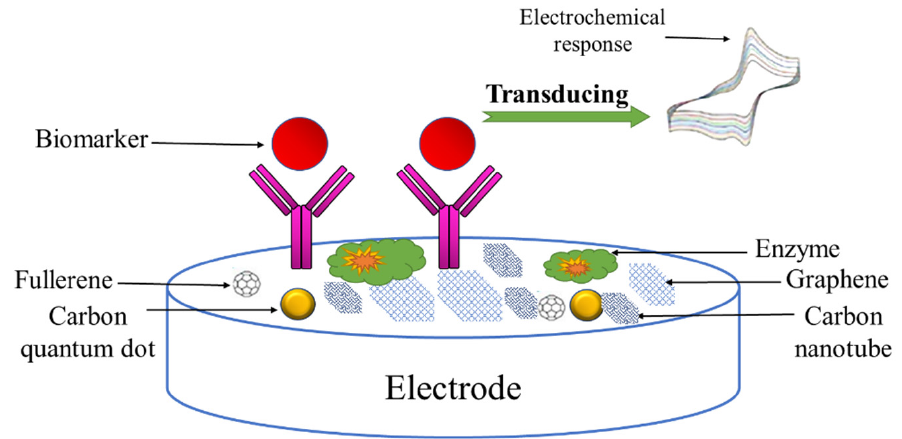
Figure 6. Schematic diagram of an electrochemical biosensor based on nanomaterials.